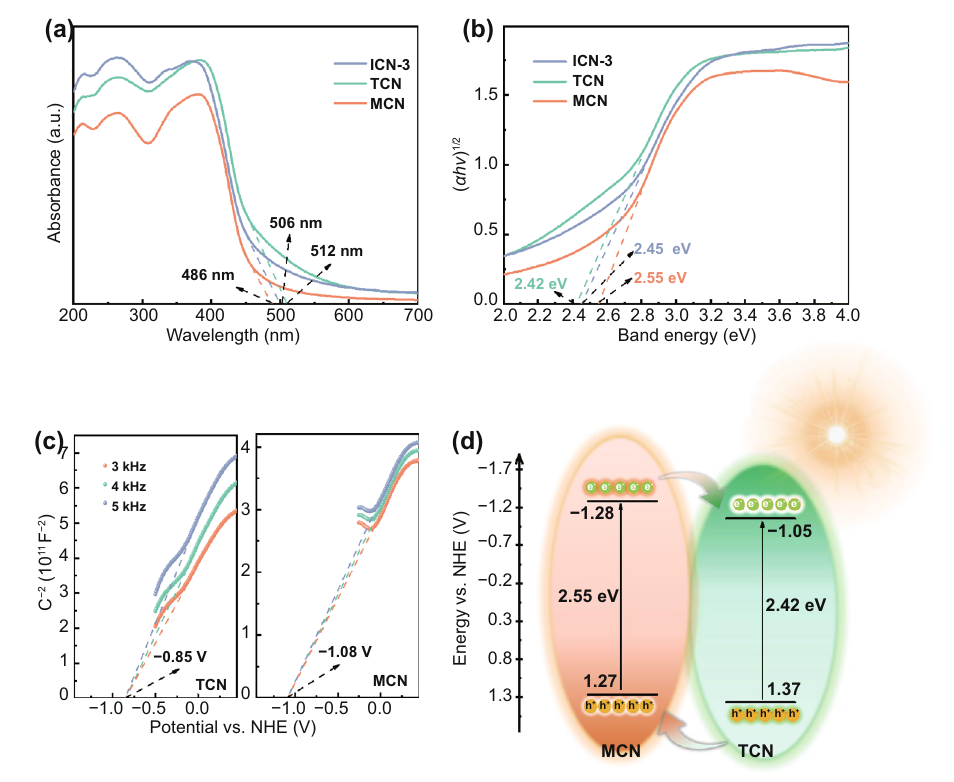
Fig. 3 a UV-DRS spectra. b Corresponding Tauc plots of as-obtained photocatalysts. c The Mott–Schottky plots of TCN and MCN. d Sche- matic of electrons–holes separation and transfer at the interface between TCN and